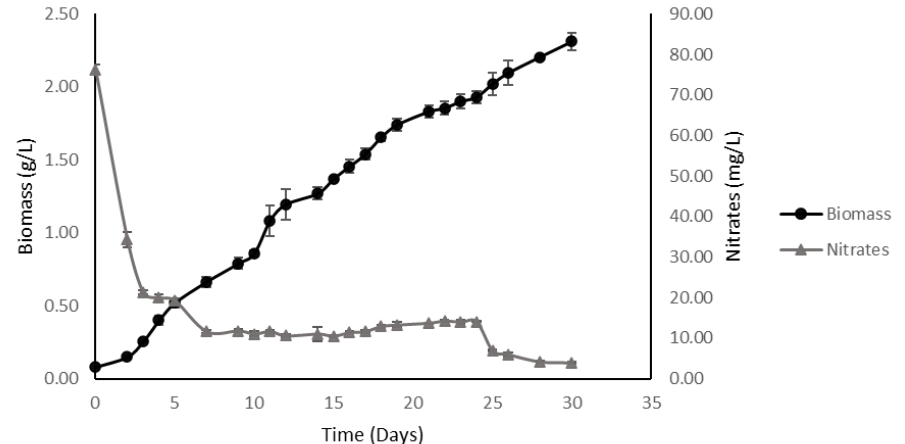
Figure 4. Growth kinetics of M. salina in fed-batch cultures. Cultures were fed with the same culture medium generated for batch cultures under high-density conditions, feeding them with a flow rate equal to 1.5 mL/h. Growth curve expressed in microalgal dry biomass (g/L) and dissolved nitrates (mg/L) in culture as a function of time.